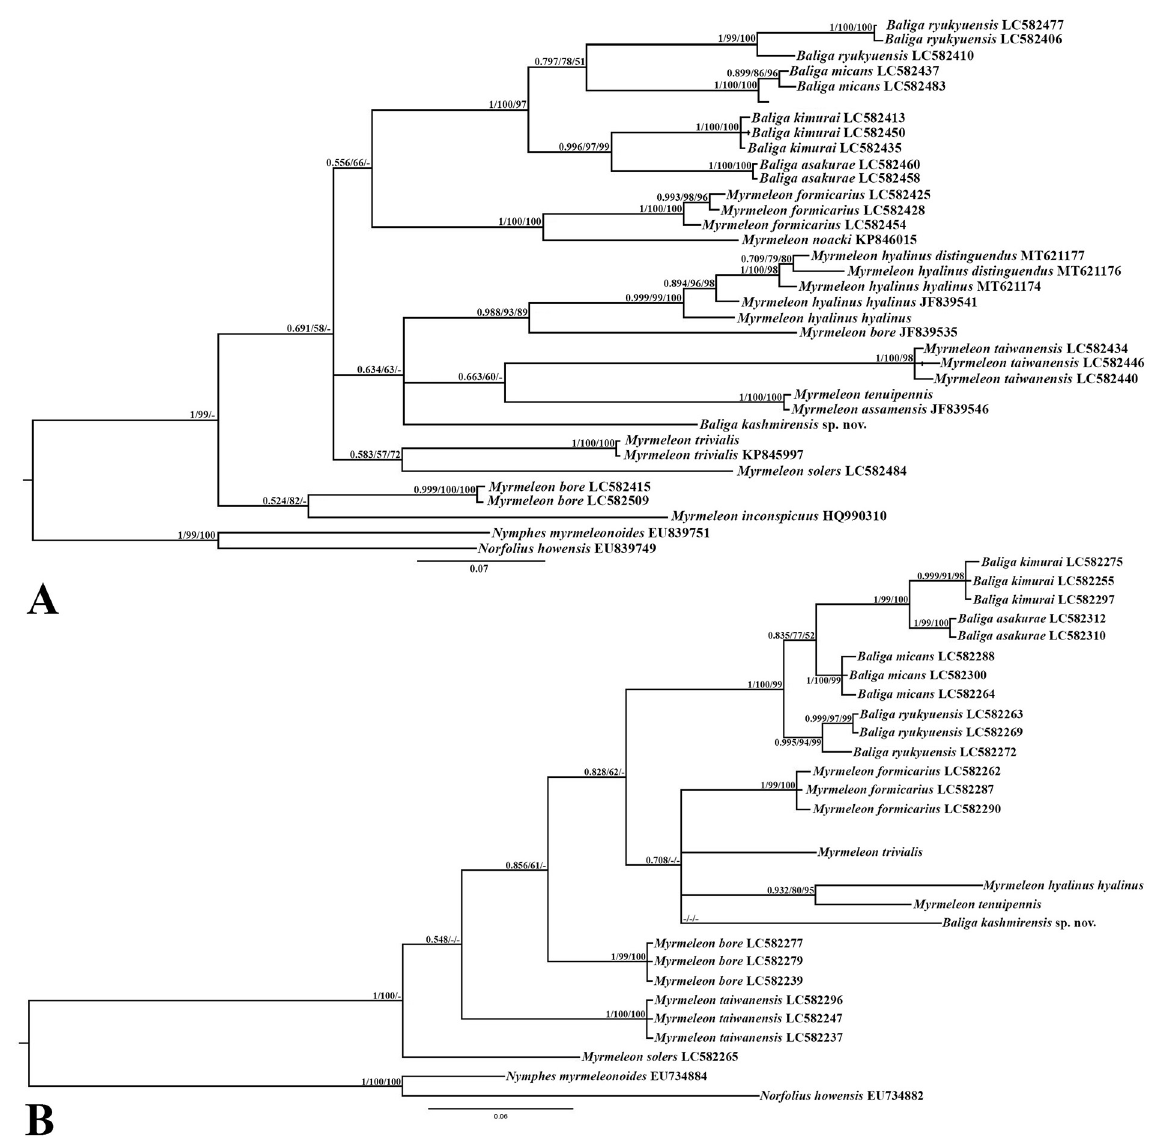
Fig. 21. Phylogenetic relationships among the species of Baliga Navás, 1912 and Myrmeleon Linnaeus, 1767 from Pakistan, China, Egypt, Greece, and Japan, based on COI (A) and 16S rRNA (B) genes. The numbers at each node show the posterior probabilities and bootstrap values more than 50% in BI/ML/ NJ